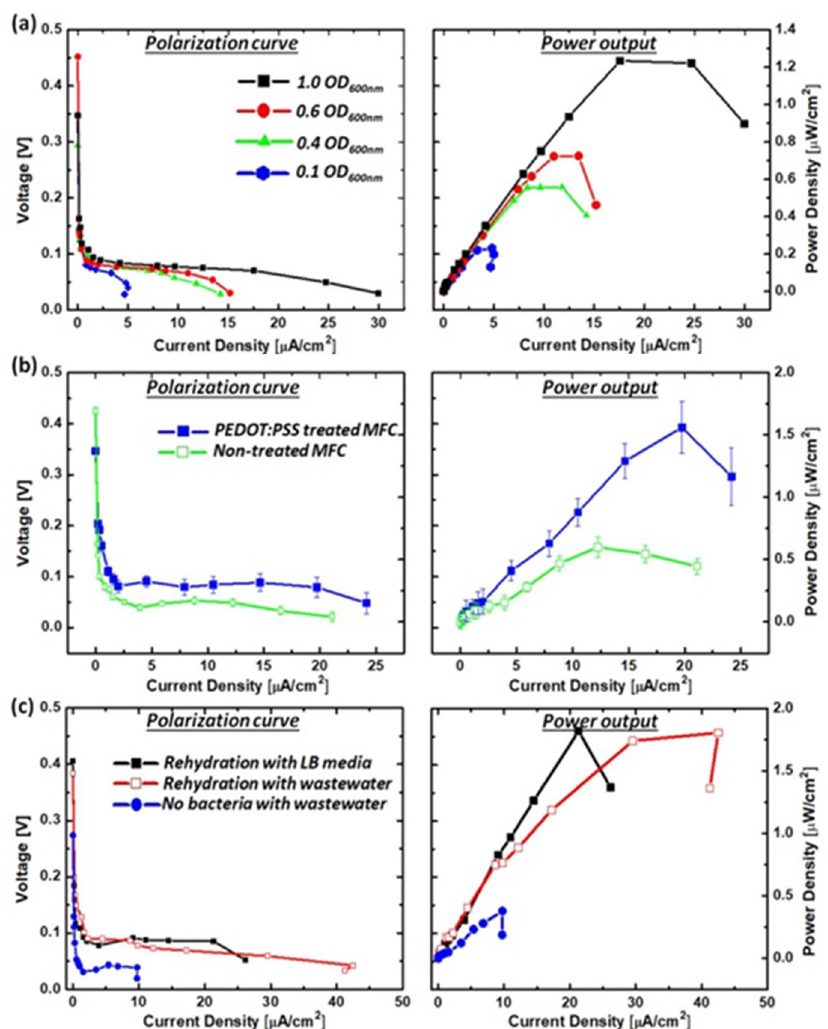
Figure 7. Polarization curves and power outputs measured from the single MFCs ( a ) with different concentrations of non-freeze-dried bacterial cells; ( b ) with 1.0 OD600 culture of non-freeze-dried cells in the anodic chamber with or without PEDOT:PSS treatment; and ( c ) with rehydrated freeze-dried cells (1.0 OD600 culture) in a different liquid. A control without bacterial cells was also prepared for comparison.